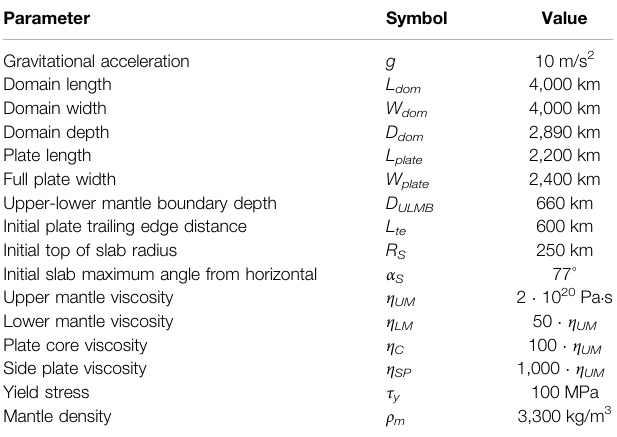
TABLE 2 | Parameters common to all simulations. Plate length, L plate , is in the direction of subduction and plate width, W plate , is along strike. Note the simulated width is half the full plate width, assuming symmetry at the